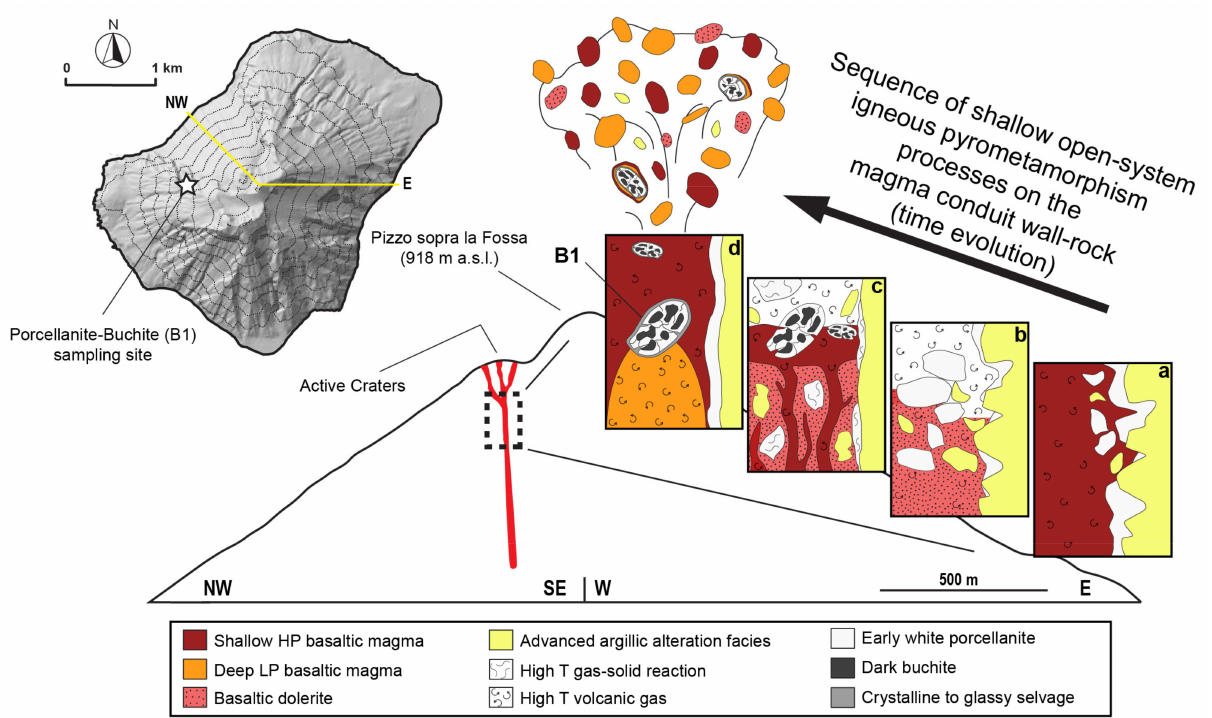
Figure 10. Simplified sketch (in four stages, a – d ) explaining the petrogenetic history of the B1 porcellanite–buchite xenolith (erupted during the 5 April 2003 paroxysm, stage d ) in the subvolcanic environment of Stromboli volcano. The sketch is envisaged for processes that occurred before (stage a ) and during the 2002–2003 eruptive crisis of Stromboli (from January to late March 2003, stages b–c ). The 2002–2003 eruptive crisis included an effusive eruption lasting six months (from 28 December 2002 to July 2003; [90,91]) and the violent explosion (paroxysm) that occurred on 5 April 2003 [79] while the lava effusion was still in progress. During this eruptive crisis, the normally persistent summit activity ceased from January to late March 2003, whereas the HP basaltic magmas continued to be outpoured as lavas from vents in the lower flanks of the volcano, along the Sciara del Fuoco